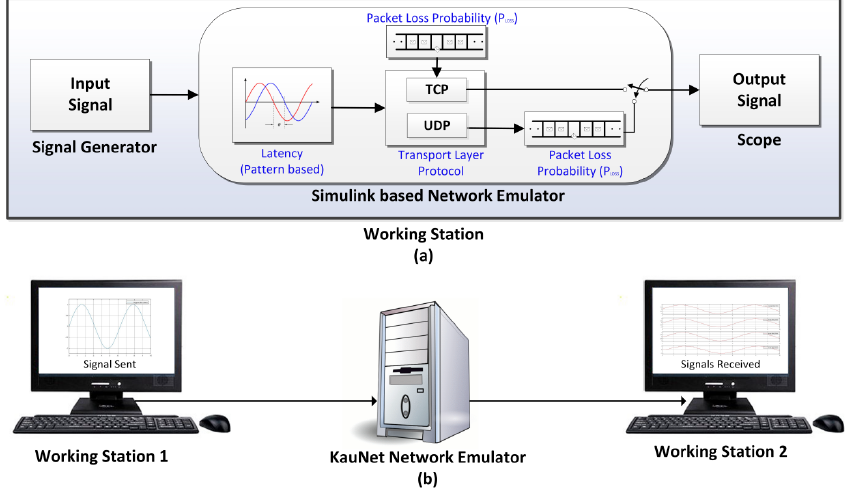
Figure 9. Test Setup: ( a ) non-RT network simulation; and ( b ) RT network emulation.